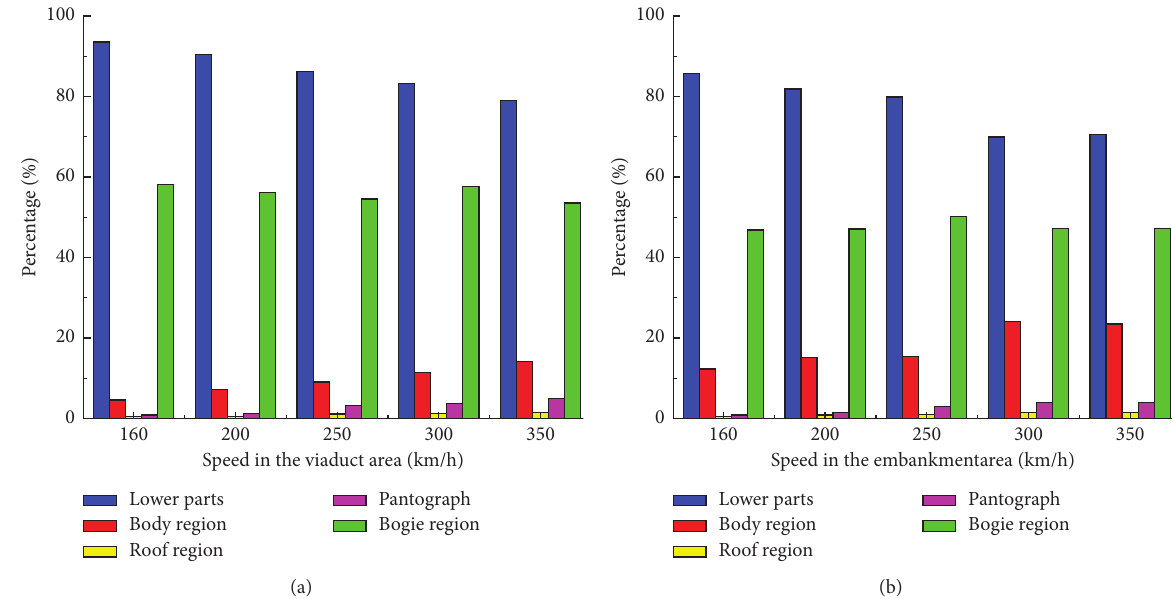
Figure 9: Contribution of each part to the total sound power of the train. (a) Contribution of each part to the total sound power of the train in the viaduct section. (b) Contribution of each part to the total sound power of the train in the embankment section.